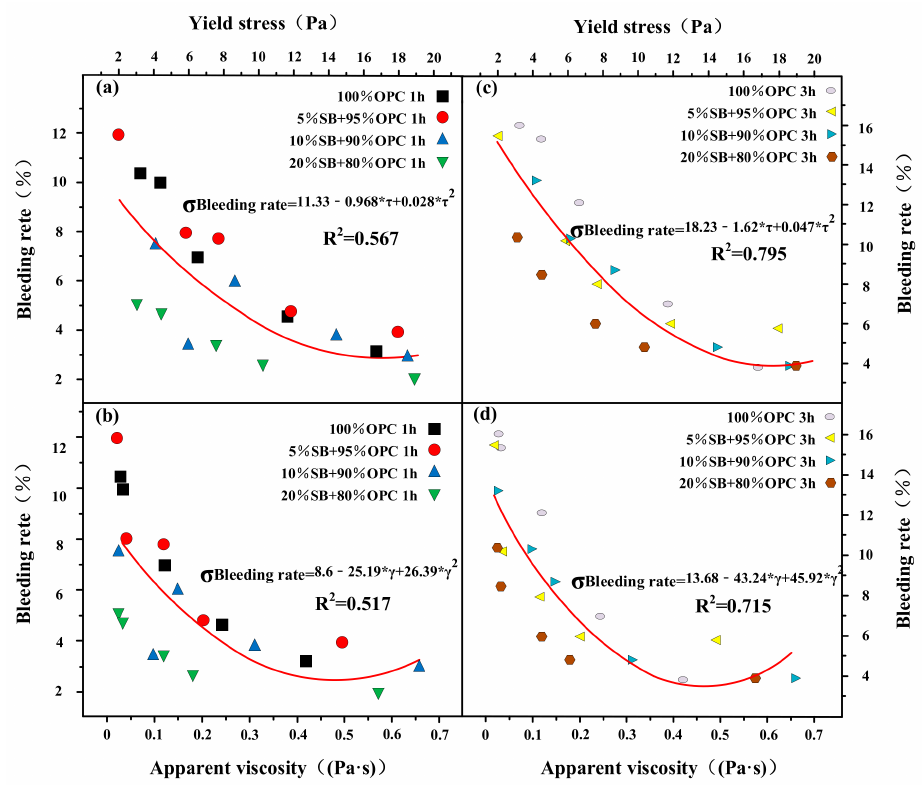
Figure 14. Apparent viscosity and yield stress versus 1 h ( a,b ) and 3 h ( c,d ) bleeding